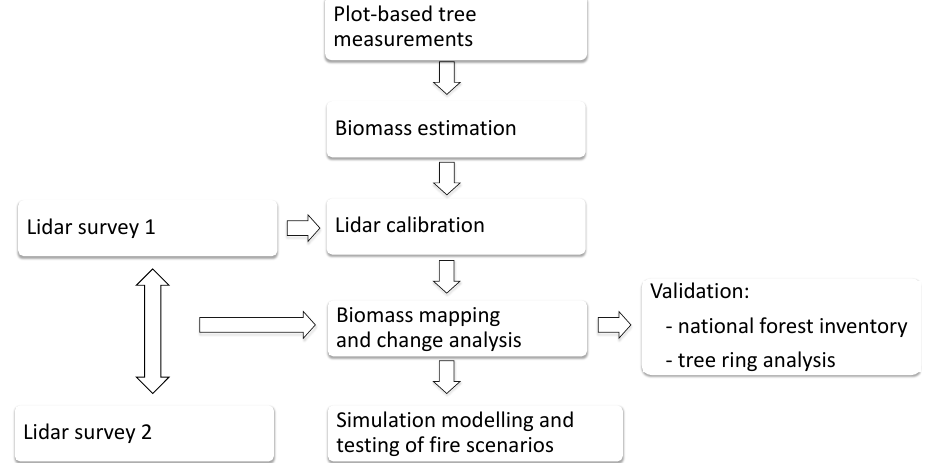
Figure 1. Methodological approach.